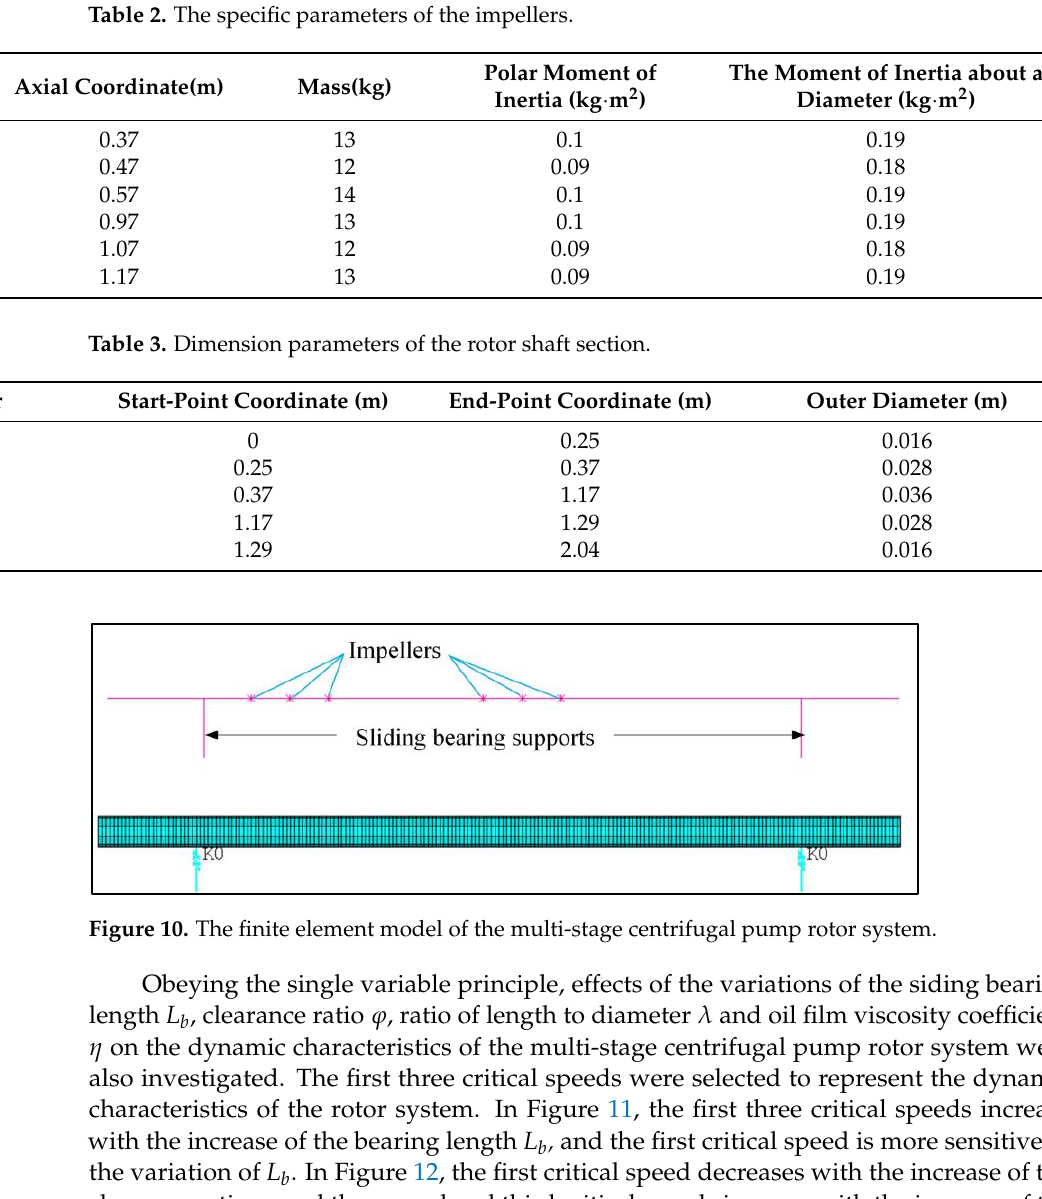
Table 3. Dimension parameters of the rotor shaft section.